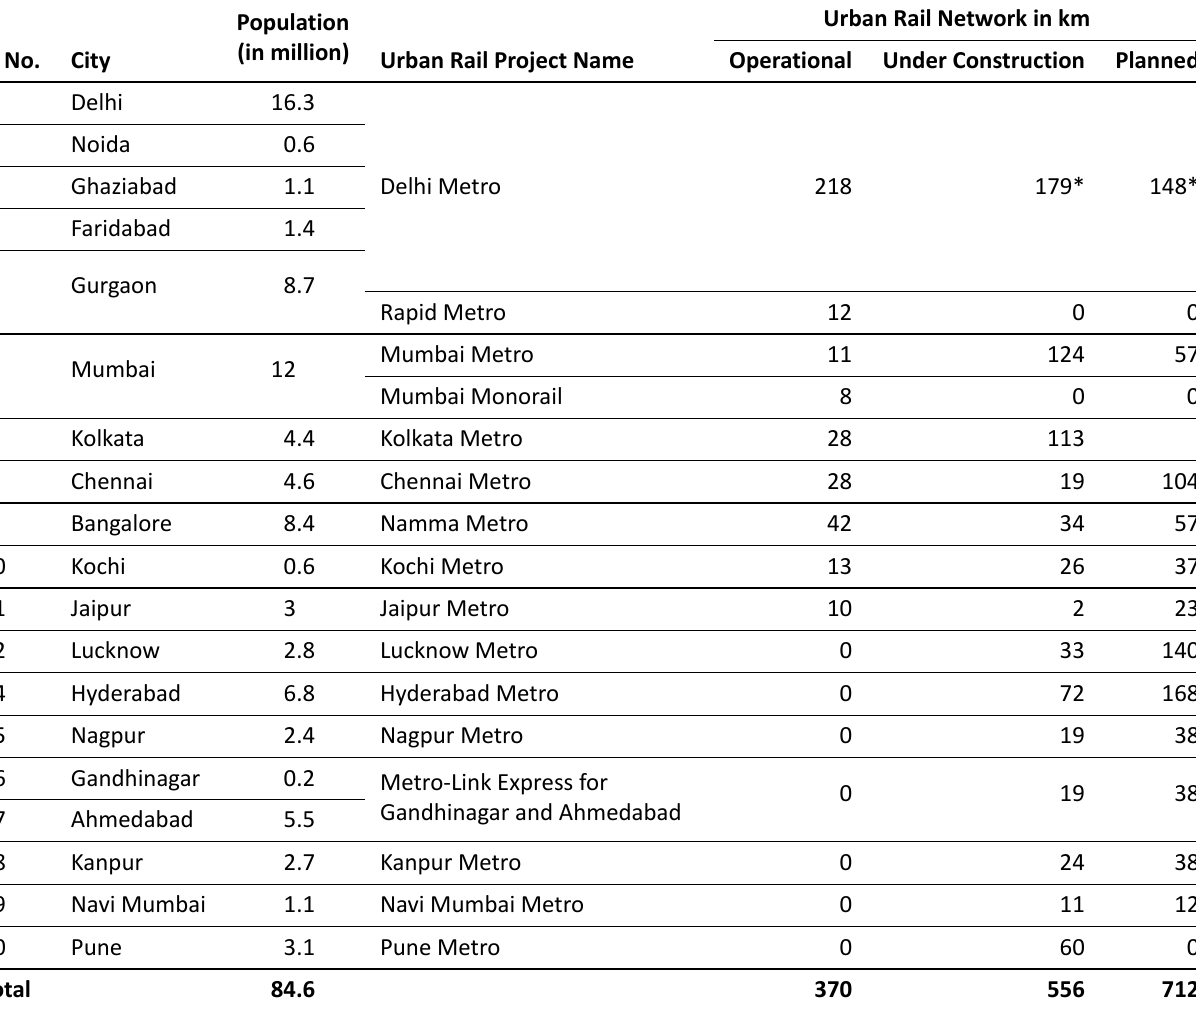
Table 2. Urban rail network in Indian cities.